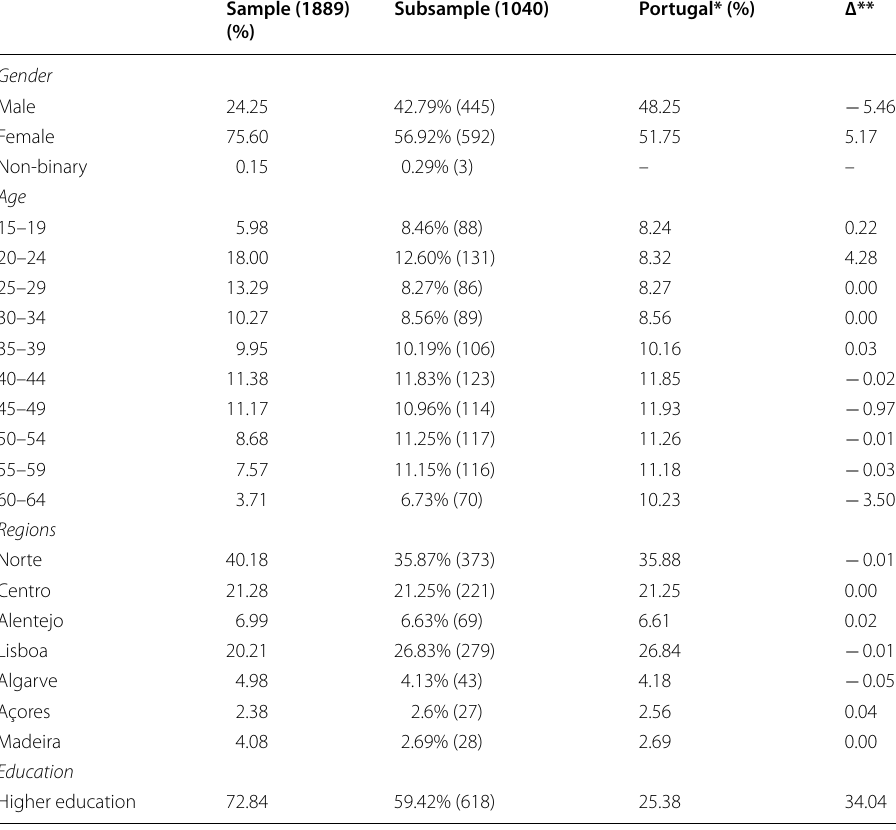
Table 1 Demographic characteristics of survey responses